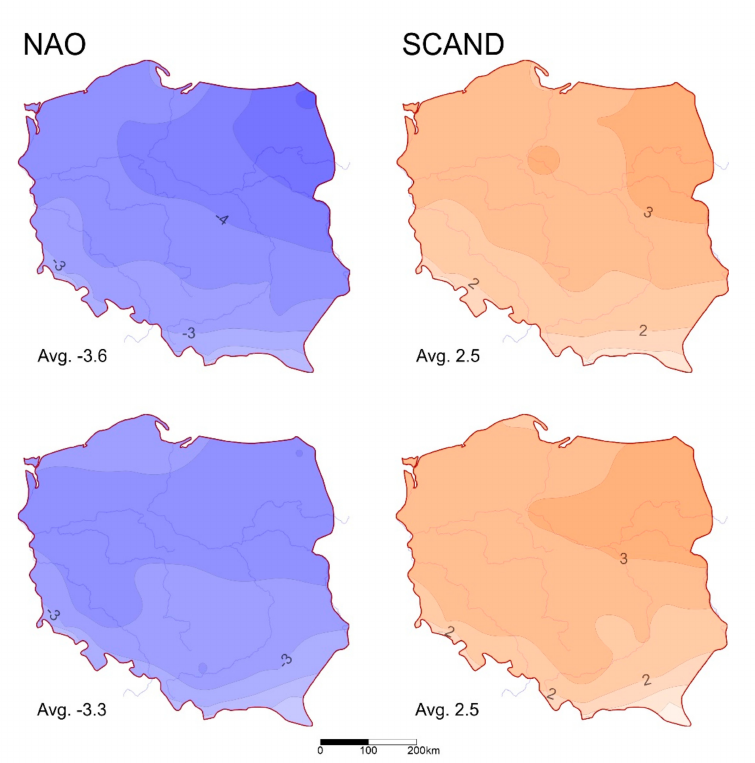
Figure 8. Difference in Tmin ( top maps ) and Tmax ( bottom maps ) between the negative and positive phase of teleconnec- tion patterns.